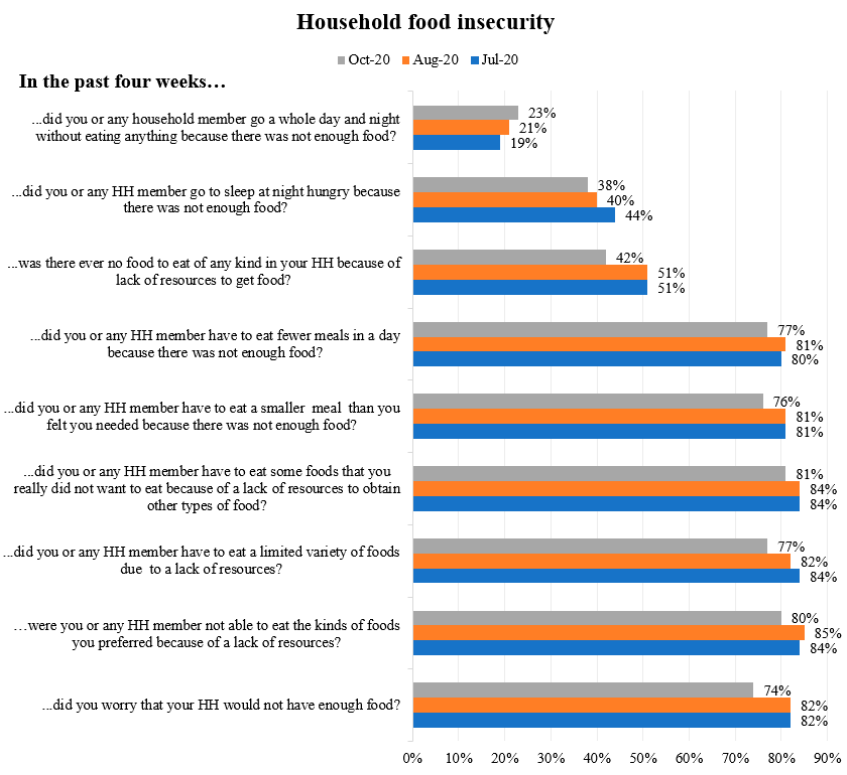
Figure 3. Household food insecurity. Table 3. Uptake of HIV testing and counseling before and during COVID-19.